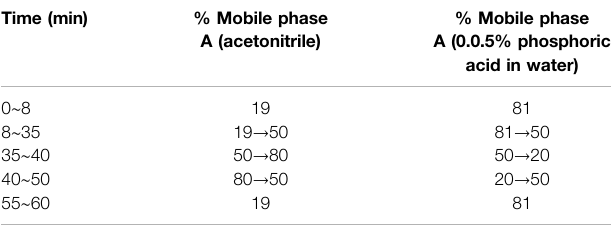
TABLE 1 | Elution conditions.